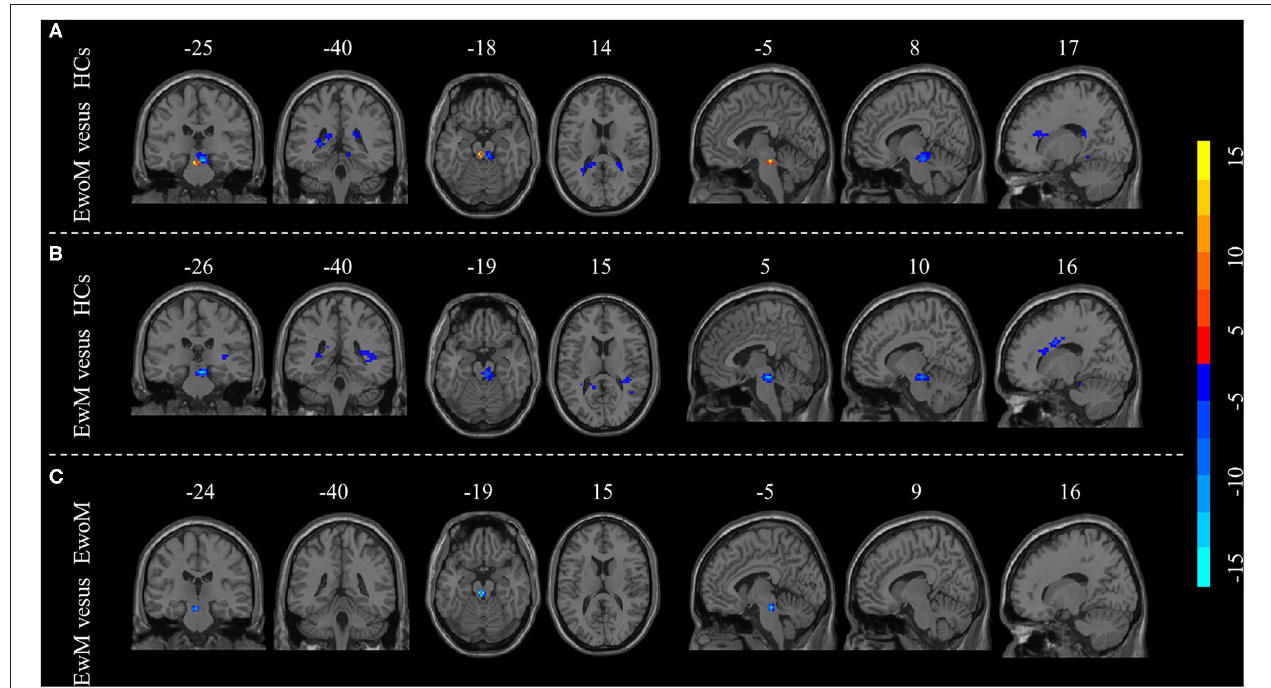
FIGURE 2 | Group differences in resting-state functional connectivity (RsFC) to PAG. (A) Differences in RsFC to PAG between the EwoM group and HCs group; (B) Differences in RsFC to PAG between the EwM group and HCs group; (C) Differences in RsFC to PAG between the EwoM group and EwM group.